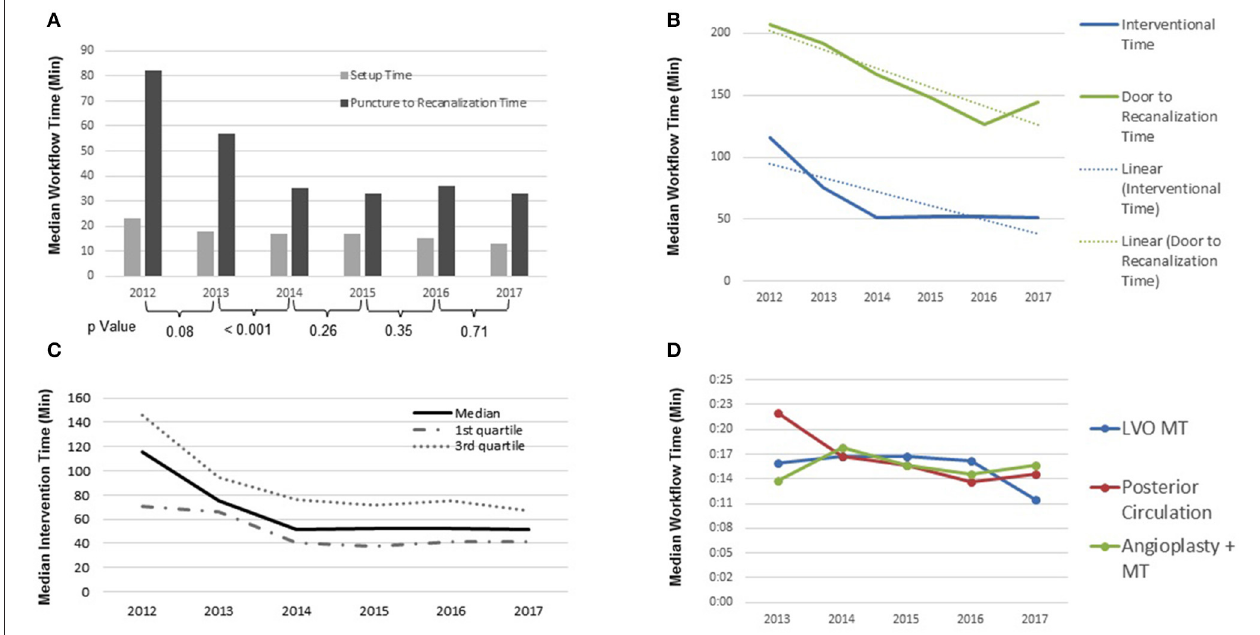
FIGURE 2 | (A) Intraprocedural time: median setup time and puncture to recanalization time ( p -values of individual years 2012–2017; 0.08, < 0.001, 0.26, 0.35, 0.71); (B) periprocedural time: median interventional time and door to recanalization time 2012–2017 (Ratio of the linear regressions: y = − 15.166x + 217.01, R ²